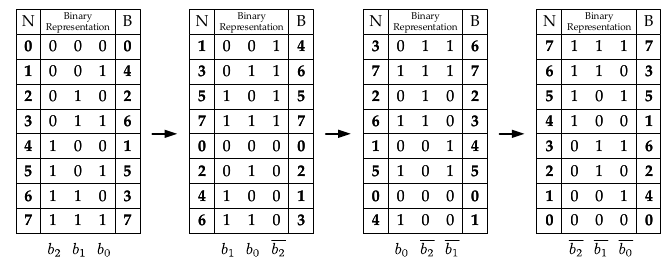
Figure 6. Addressing scheme example for odd-indexed memories ( N = 16 and β = 1).